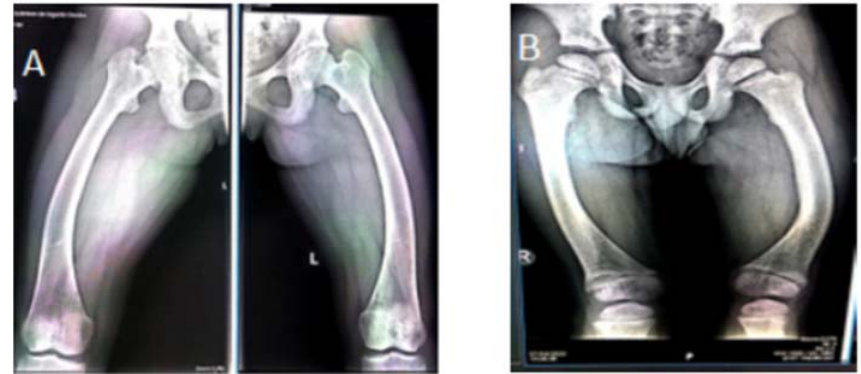
Figure 3. Femoral radiography (April 2022): femoral scoliosis, ( A ) case #1, ( B ) case #2.